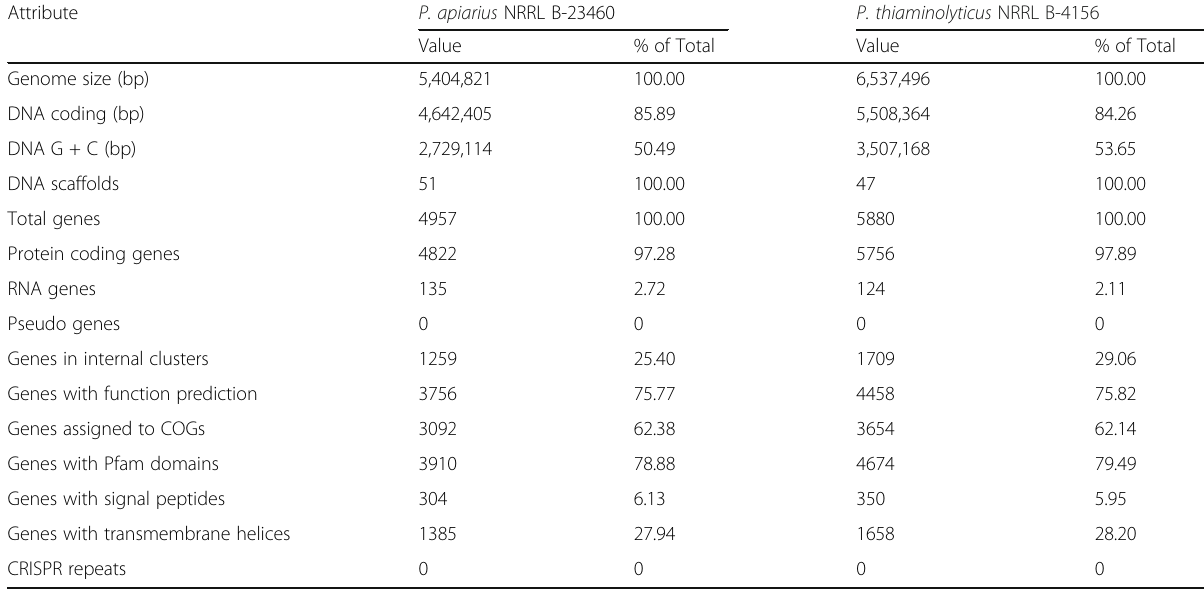
Table 4 Genome and annotation statistics for P. apiarius and P. thiaminolyticus